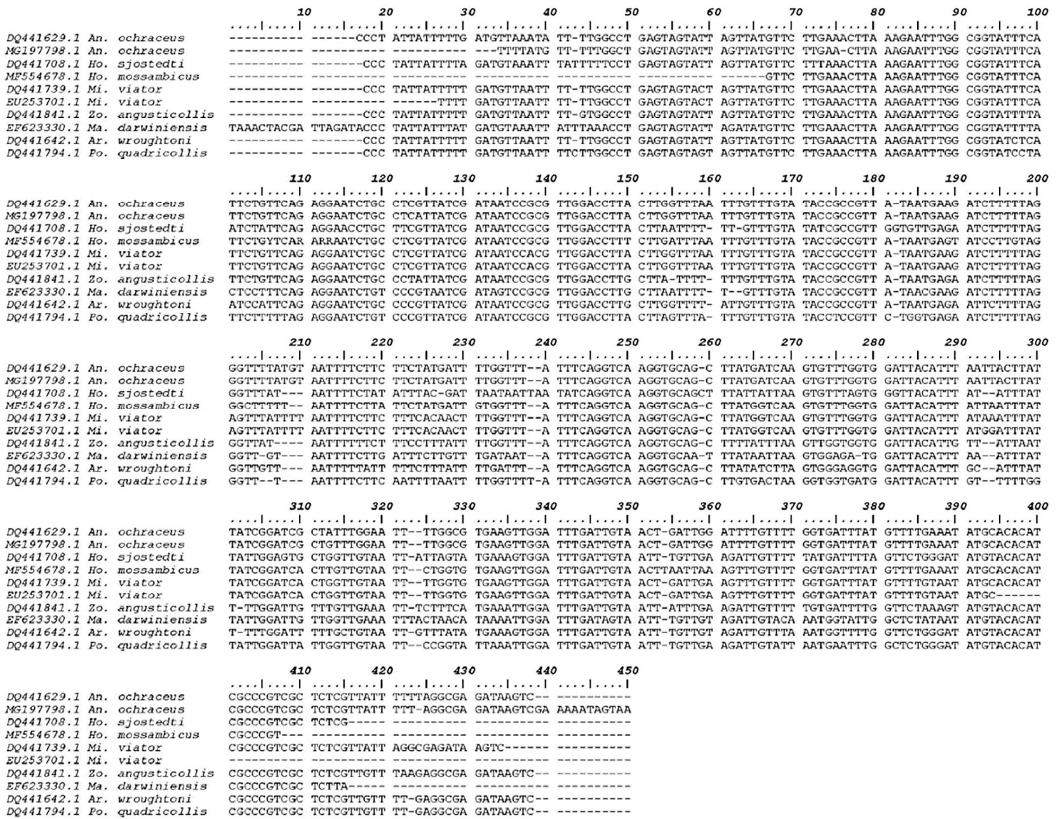
Figure 1. Sequence alignment of the 12S rRNA of A. ochraceus with the most related species (Only variable sites are shown. Dots represent the bases identical to those of the first sequences, and dashes indicate gaps).